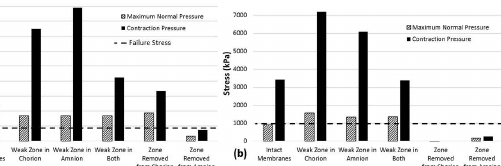
Fig 6. Maximum predictedstress in (a) the chorion and (b) the amnionunder applicationof both maximum normalintrauterinepressure and pressureduringcontractions, with a weak zone in either membrane, in both, or with a zone removedcompletely.Dashedlines indicate the failure stress of the chorion and fetal membrane in (a) and (b), respectively.